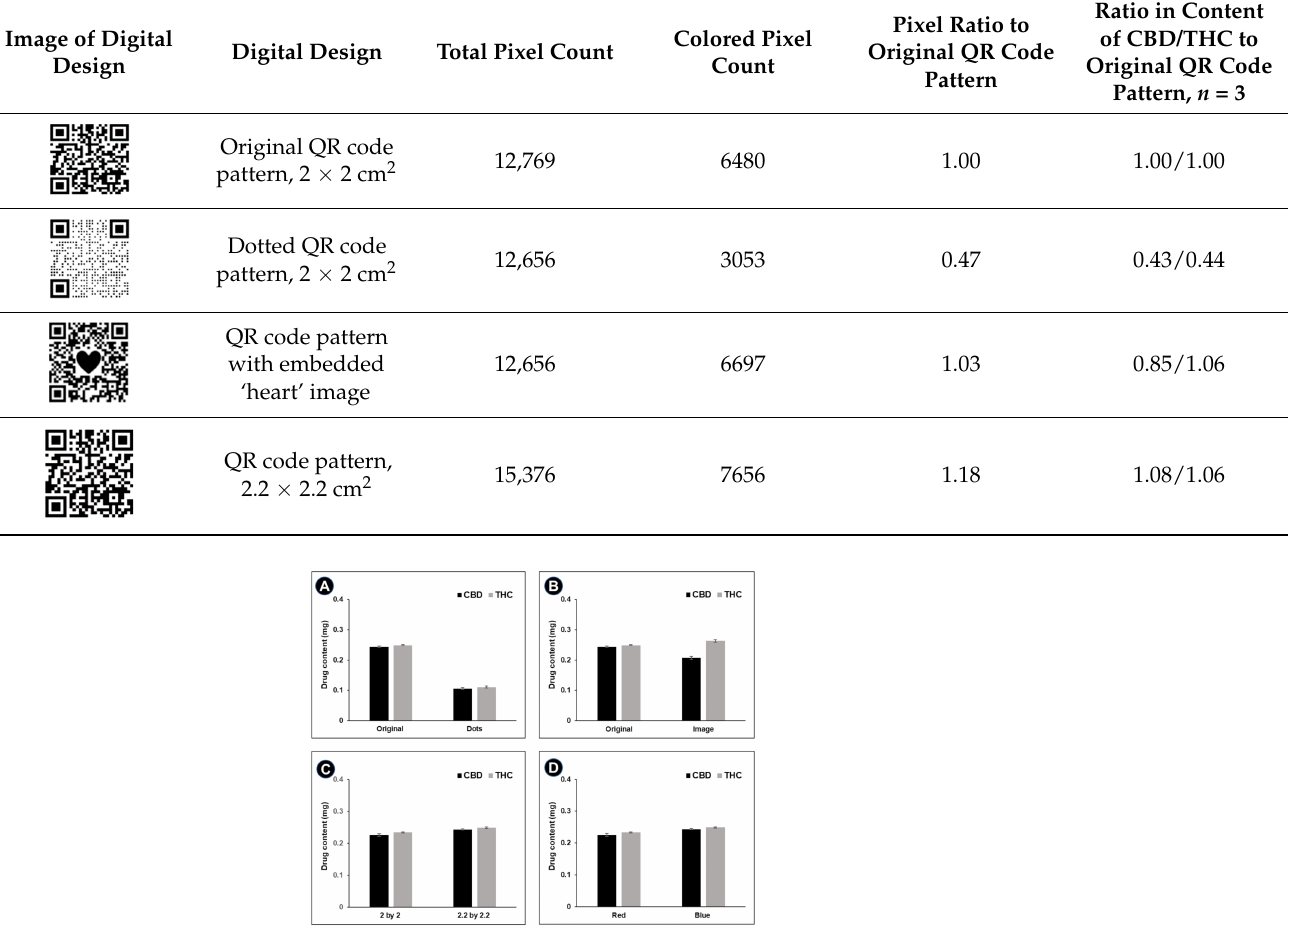
Table 1. The pixel counts of digital designs of the printed patterns.